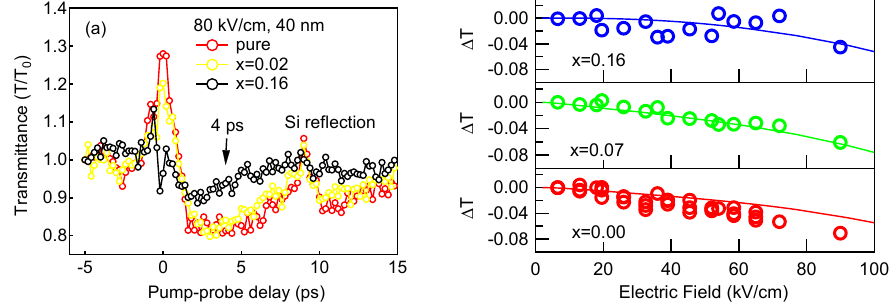
Fig. 2. (a) Normalized transient transmittance change of Bi 1- x Sb x thin films as a function of the pump-probe delay time. The transmittance is evaluated by the ratio of the peak electric filed strength for the sample with that for the reference Si substrate. (b) The transmittance change at the pump-probe delay time of 4 ps as a function of the pump electric field strength for samples with different antimony concentrations. Solid lines indicate the calculation using the probability of the Zener tunneling and the band structure of Bi 1- x Sb x reported for bulk crystals